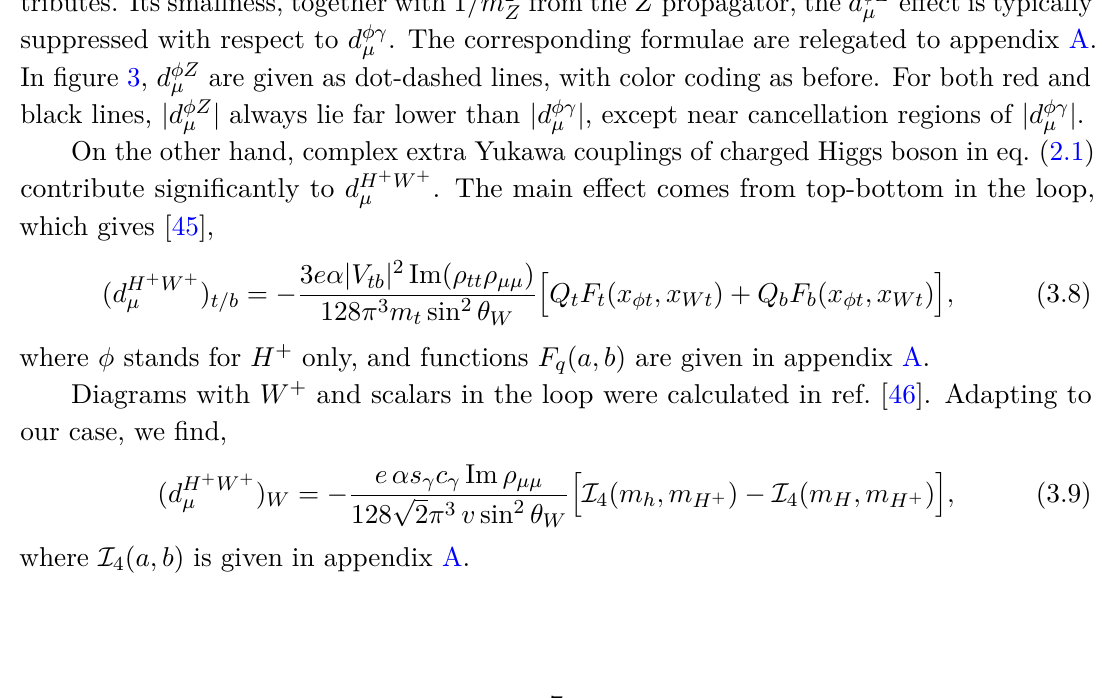
| , | d H + W + | , and | d φZ | , µ µ µ